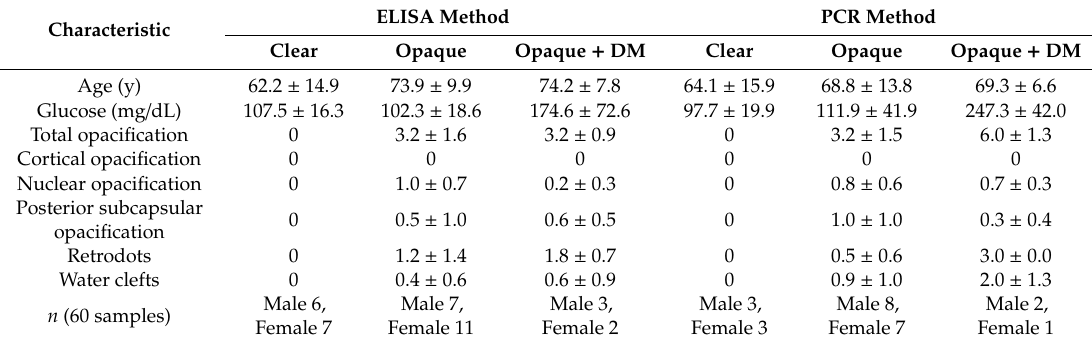
Table 1. The characteristics of the donors in this study.